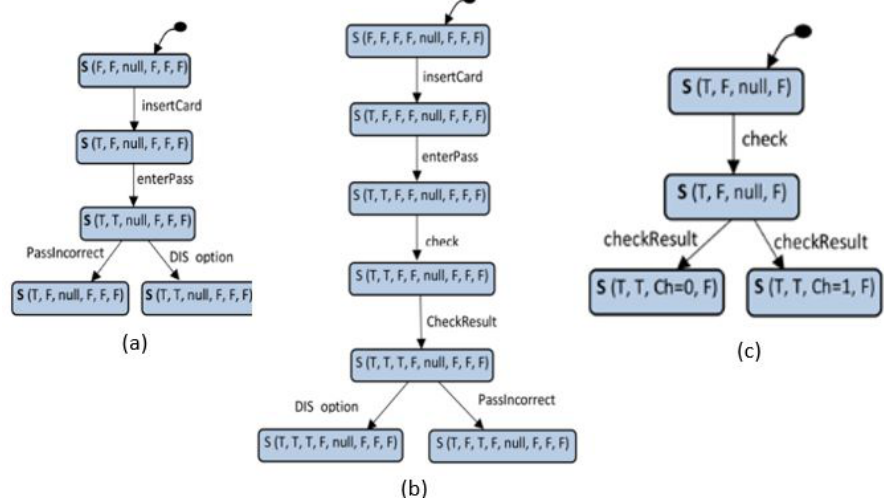
Figure 5. The FSMs obtained from the password verification scenario. ( a ) FSM UI component. ( b ) FSM of ATM component. ( c ) FSM of Bank